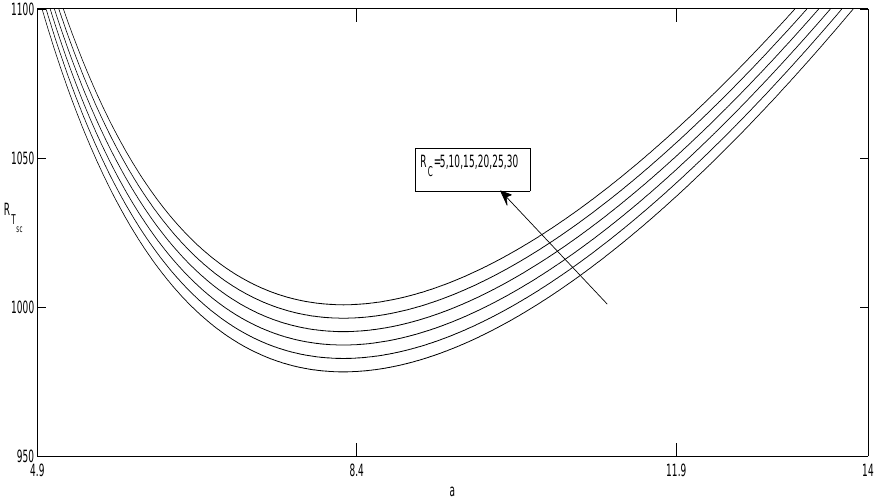
Figure 4. Neutral curves for the different values of R C and for the fixed values of γ = 0.5, η = 0.2, κ r = 1, S = 0.2, and Ta = 50 for the stationary